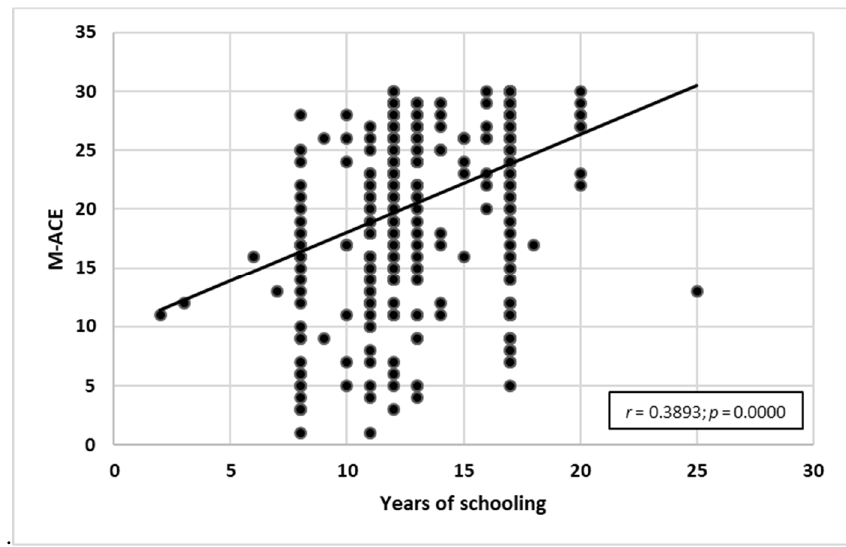
Figure 6. Years of schooling correlated with M-ACE test results.